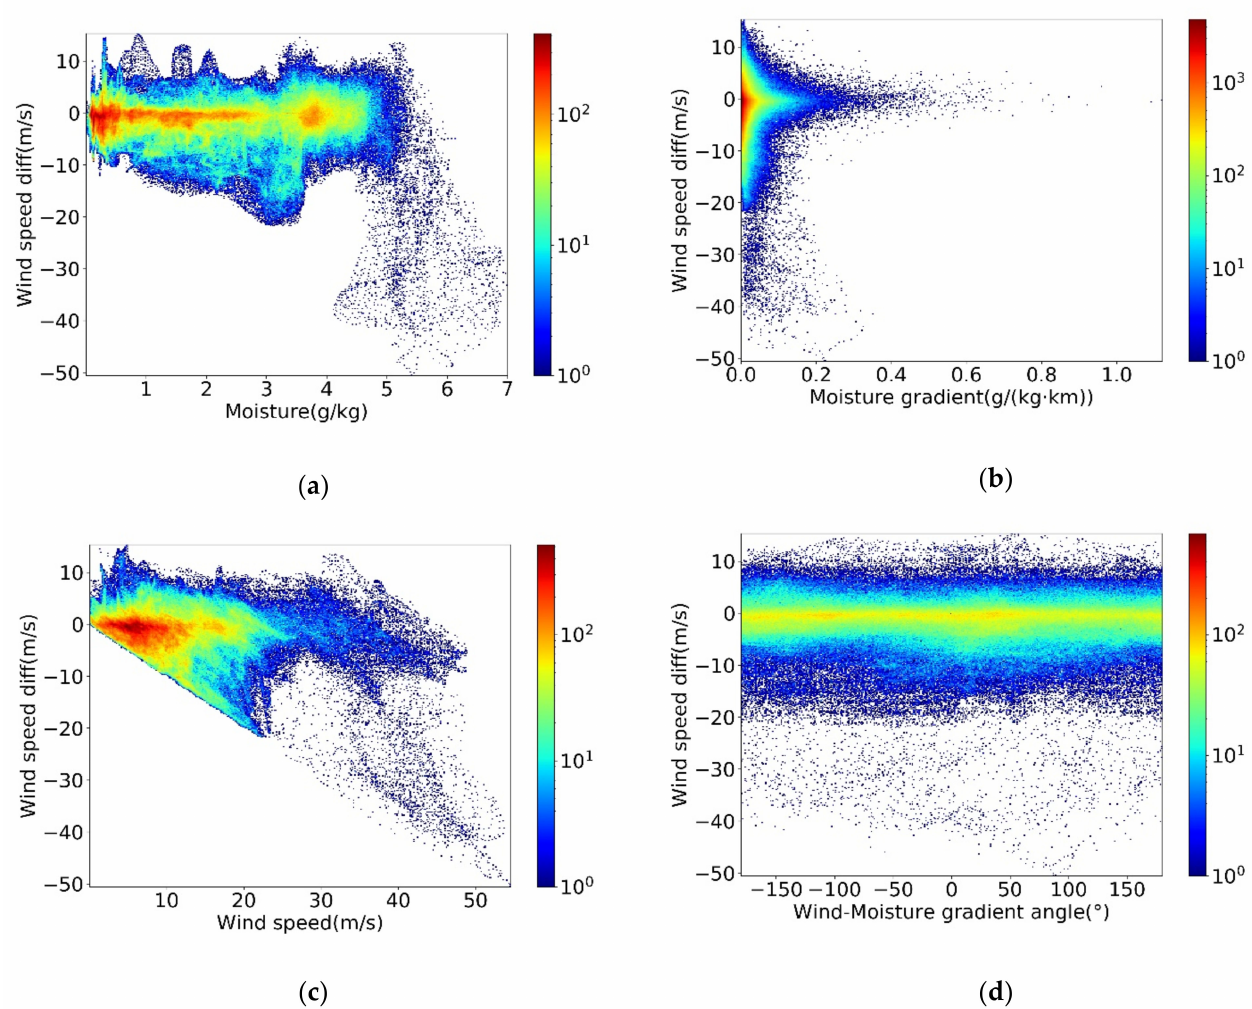
Figure 11. The wind speed AE as a function of water vapor content ( a ), water vapor gradient ( b ), wind speed ( c ), and wind–moisture gradient angle ( d ) at 400